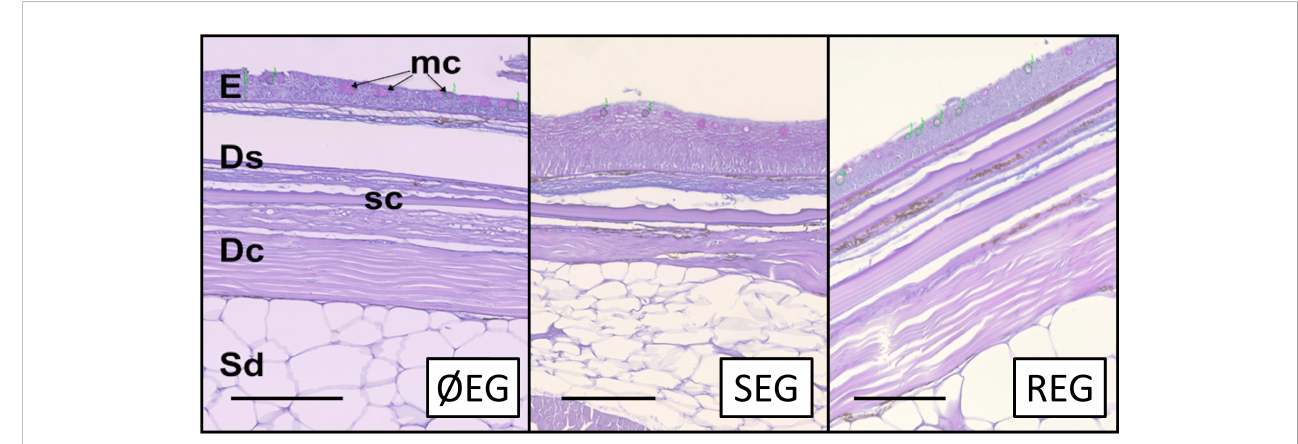
FIGURE 3 Histological sections for non-sampled (ØEG), single-sampling (SEG), and repeated-sampling (REG) treatments (N = 5). The epidermis (E) presented magenta-stained mucous cells (mc) showing neutral mucin. The stratum spongiosum (Ds) and stratum compactum (Dc) of the dermis as well as the scales (sc) and subdermal space (Sd) presented no abnormalities. Stain: PAS and Alcian blue. Scale bar: 100 µm.